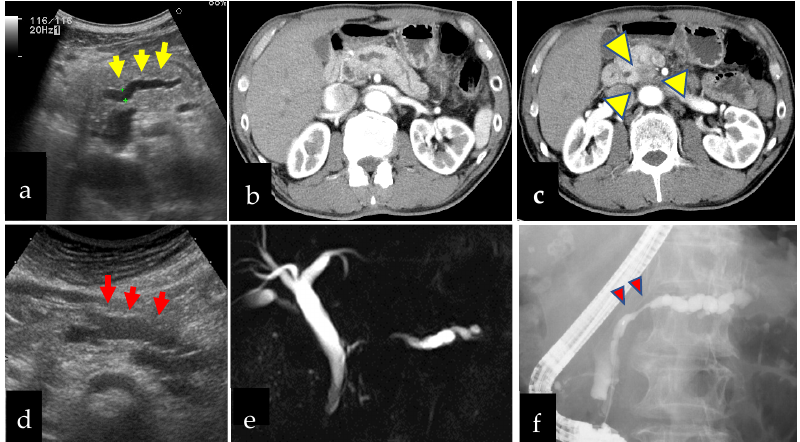
Figure 2. Two cases of pancreatic cancer found by medical checkup by abdominal ultrasonography. ( a – c ): Sixty-five-year-old man had a dilatation of the main pancreatic duct (MPD) in the body (yellow arrows) and underwent enhanced computed tomography and pancreatic head cancer was found (yellow arrowheads). He had surgery and a diagnosis of stage 2b (UICC 8th) and was alive without relapse 2621 days after surgery. ( d – f ): An eighty-year-old women had a dilatation of MPD in the pancreatic body (red arrows) and underwent magnetic resonance cholangiography and focal poor rendering of MPD was detected. Endoscopic retrograde pancreatography showed focal stenosis of MPD in the pancreatic body (red arrowheads). Serial pancreatic juice cytology showed atypical cells suspect of adenocarcinoma and was diagnosed with pancreatic intra-epithelial neoplasm-3 with